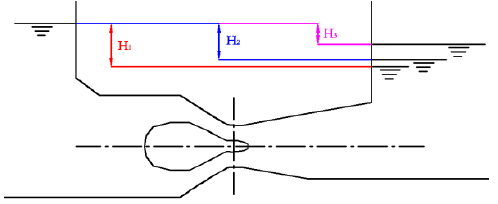
Table 1. Specific parameters at different working conditions.